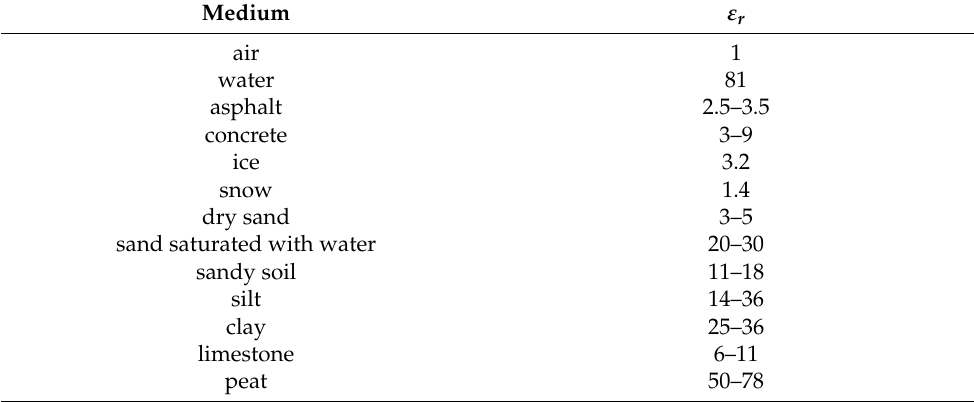
Table 2. Relative electric permittivity depending on the medium